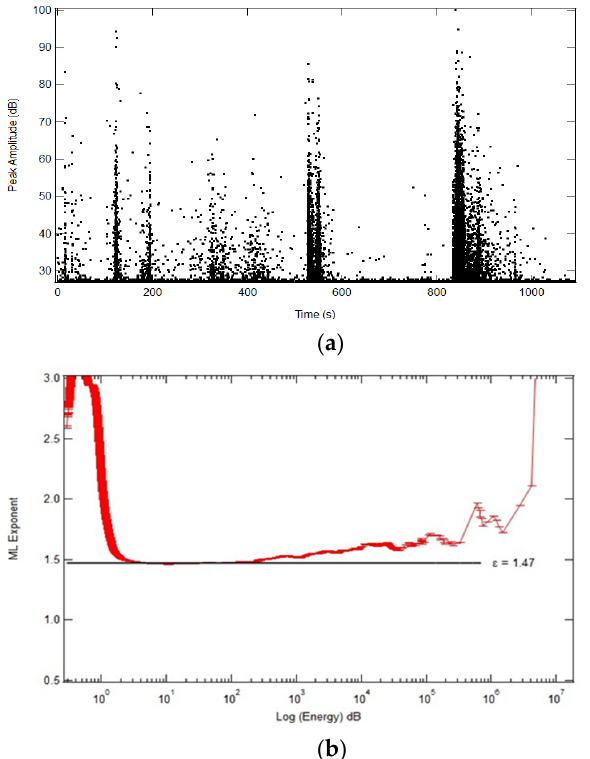
Figure 13. ( a ) Jerk spectrum showing the peak amplitude vs. time with a threshold of 23.6 dB. Each peak in this spectrum is attributed to an avalanche in the sugar lump. ( b ) ML-fitting exponent ε as a function of energy. The plateau shown by the horizontal black line is an indication of ε = 1.47 from compressing the sugar lump.